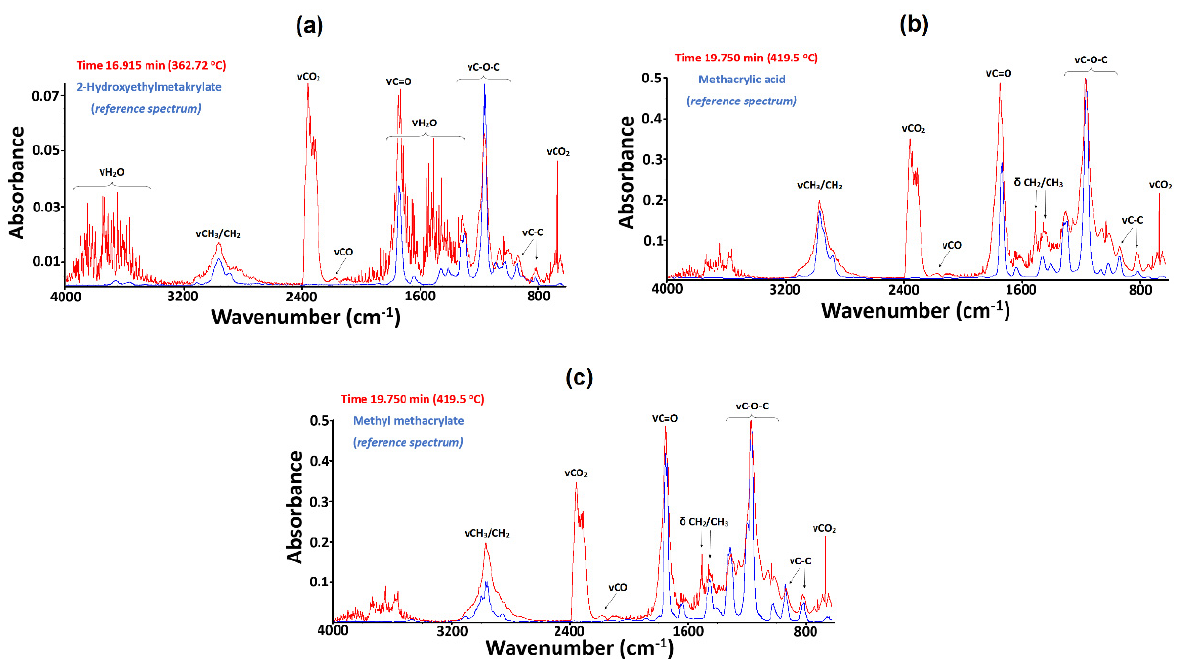
Figure 6. Experimental infrared spectra of gaseous products recorded in the nitrogen atmosphere at different temperatures are indicated in red, alongside FTIR spectra of references represented in blue: ( a ) 2-hydroxyethylmethacrylate, ( b ) methacrylic acid, and ( c ) methyl methacrylate.